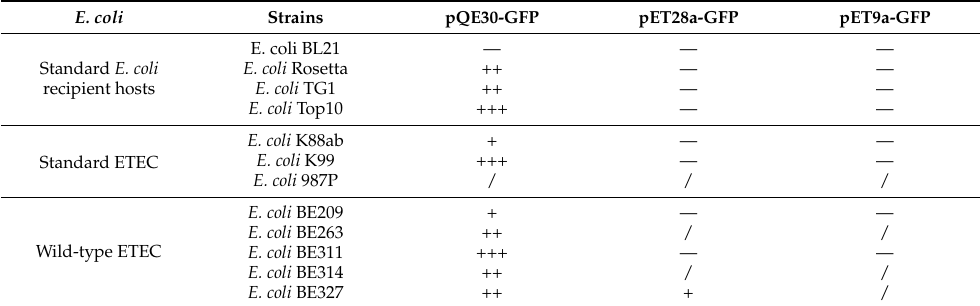
Table 1. The GFP-expressing ability of different E. coli strains and